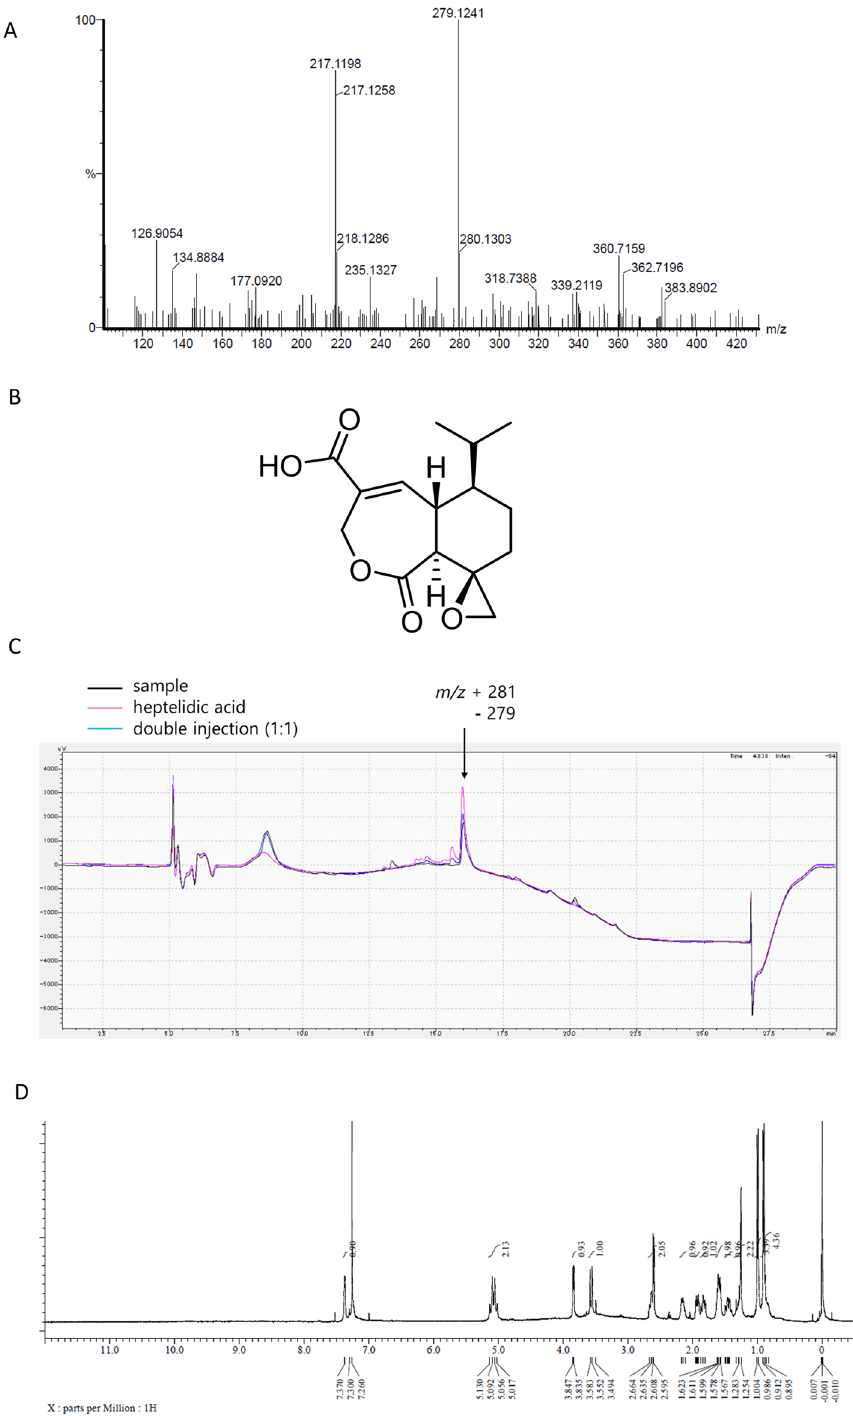
Figure 3. Heptelidic acid was contained in the separated fraction of the culture supernatant of A. oryzae . An LC-HRMS analysis showed the exact mass of the molecule contained in the final fraction ( A ). The chemical structure of heptelidic acid ( B ). The spectrum of LC confirmed heptelidic acid and the molecule contained in the final fraction to have the same retention time ( C ). The NMR analysis showed the spectrum of the molecule contained in the final fraction ( D